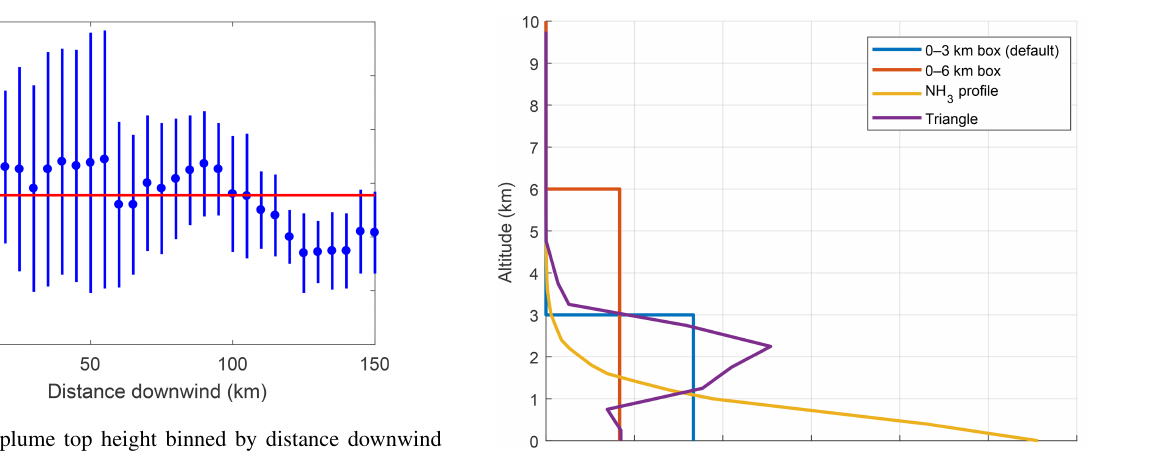
Figure 3. MISR plume top height binned by distance downwind of the fire with 1 σ standard deviation given by the error bars. The red line indicates the mean of the binned plume top height values (2.9km). Figure 4. Smoke plume profiles used in the emission estimate sen-